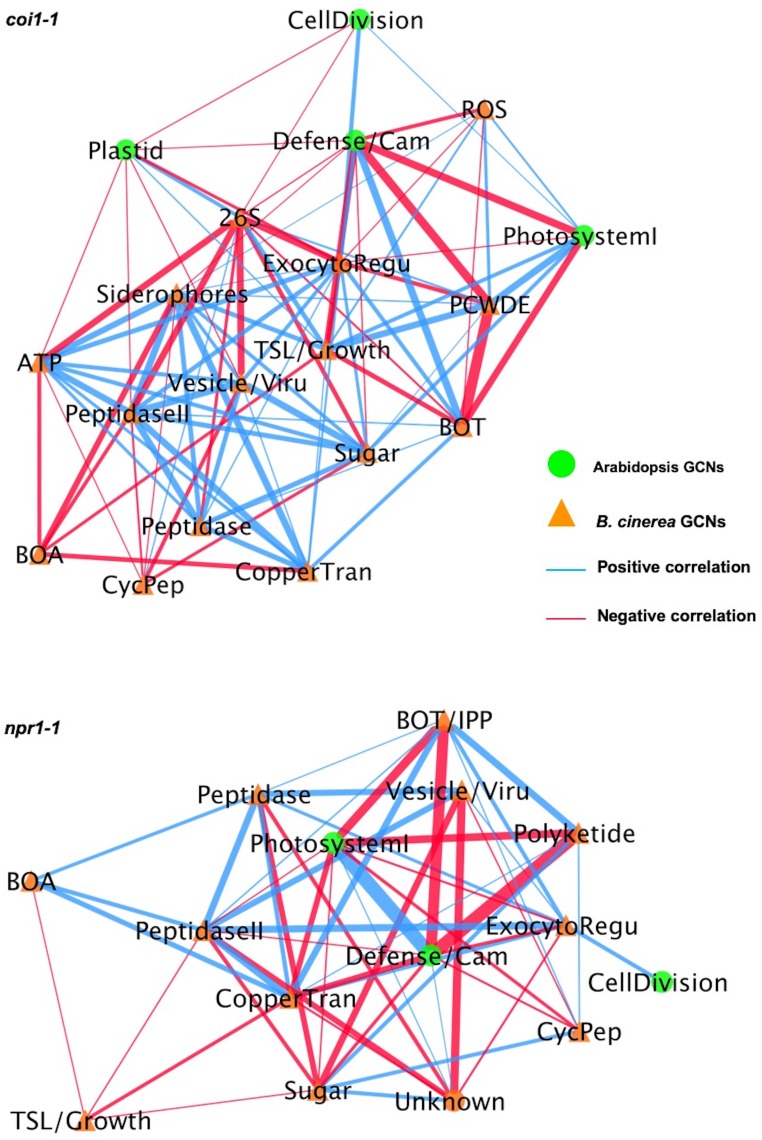
Dual networks reveal links between Arabidopsis immunity and B. cinerea virulence under coi1-1 and npr1-1.Dual interaction networks were constructed using gene co-expression networks (GCNs) from Arabidopsis and B. cinerea co-transcriptome under JA-insensitive mutant coi1-1 and SA-insensitive mutant npr1-1, respectively. The first eigenvectors were derived from individual GCNs and used as input to calculate Spearman’s rank correlation coefficiency between GCN pairs. Green dots and orange triangles (nodes) represent Arabidopsis immune- and B. cinerea virulence-GCNs, respectively. Blue and red lines (edges) represent the positive and negative Spearman’s rank correlation coefficients between GCN pairs, respectively. The thickness of line signifies the correlational strength.